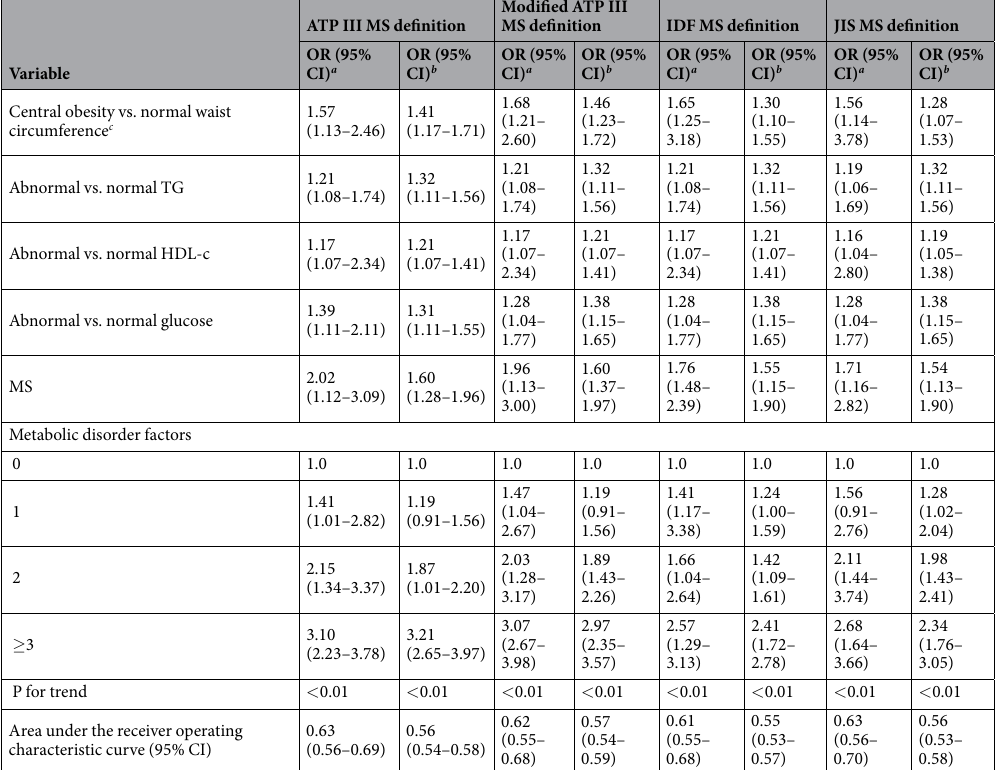
Table 5. Association of uncontrolled hypertension and metabolic risk factors among hypertension patients from baseline and the follow-up * . * Adjusted for body mass index (not including in model c ), vegetable consumption, fruit consumption, education, income, farmer status, smoking status and drinking status. a 1,515 patients with hypertension who received drug therapy among the 2,912 patients at baseline, b 2,912 patients with hypertension who were all receiving antihypertension therapy at the 1-year follow-up. OR: odds ratio, 95% CI: 95% confidence interval, TG: triglycerides; HDL-c: high-density lipoprotein cholesterol, MS: metabolic syndrome, ATP III: the Adult Treatment Panel III (part of the 2001 US Third Report of the National Cholesterol Education Program), Modified ATP III: the 2004 modification of the ATP III for Asian populations, IDF: the 2005 criteria from the International Diabetes Federation, JIS: the 2009 criteria from the Joint Interim